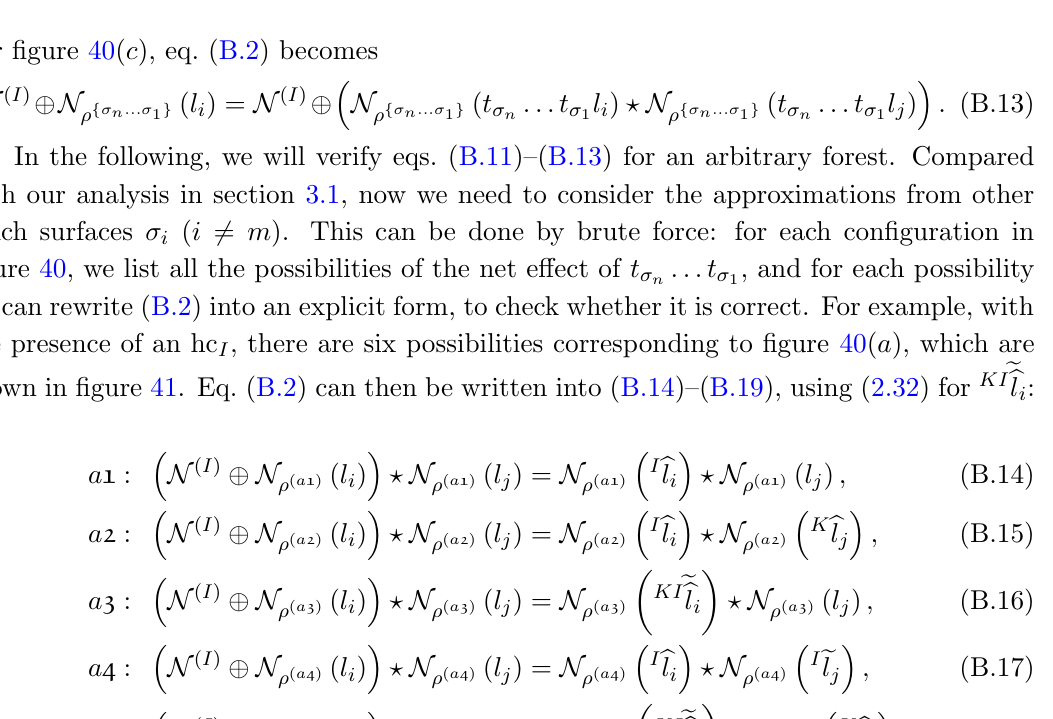
Figure 41. The six possibilities of net approximations, whose associated pinch surfaces are nested with (cid:12)gure 40( a